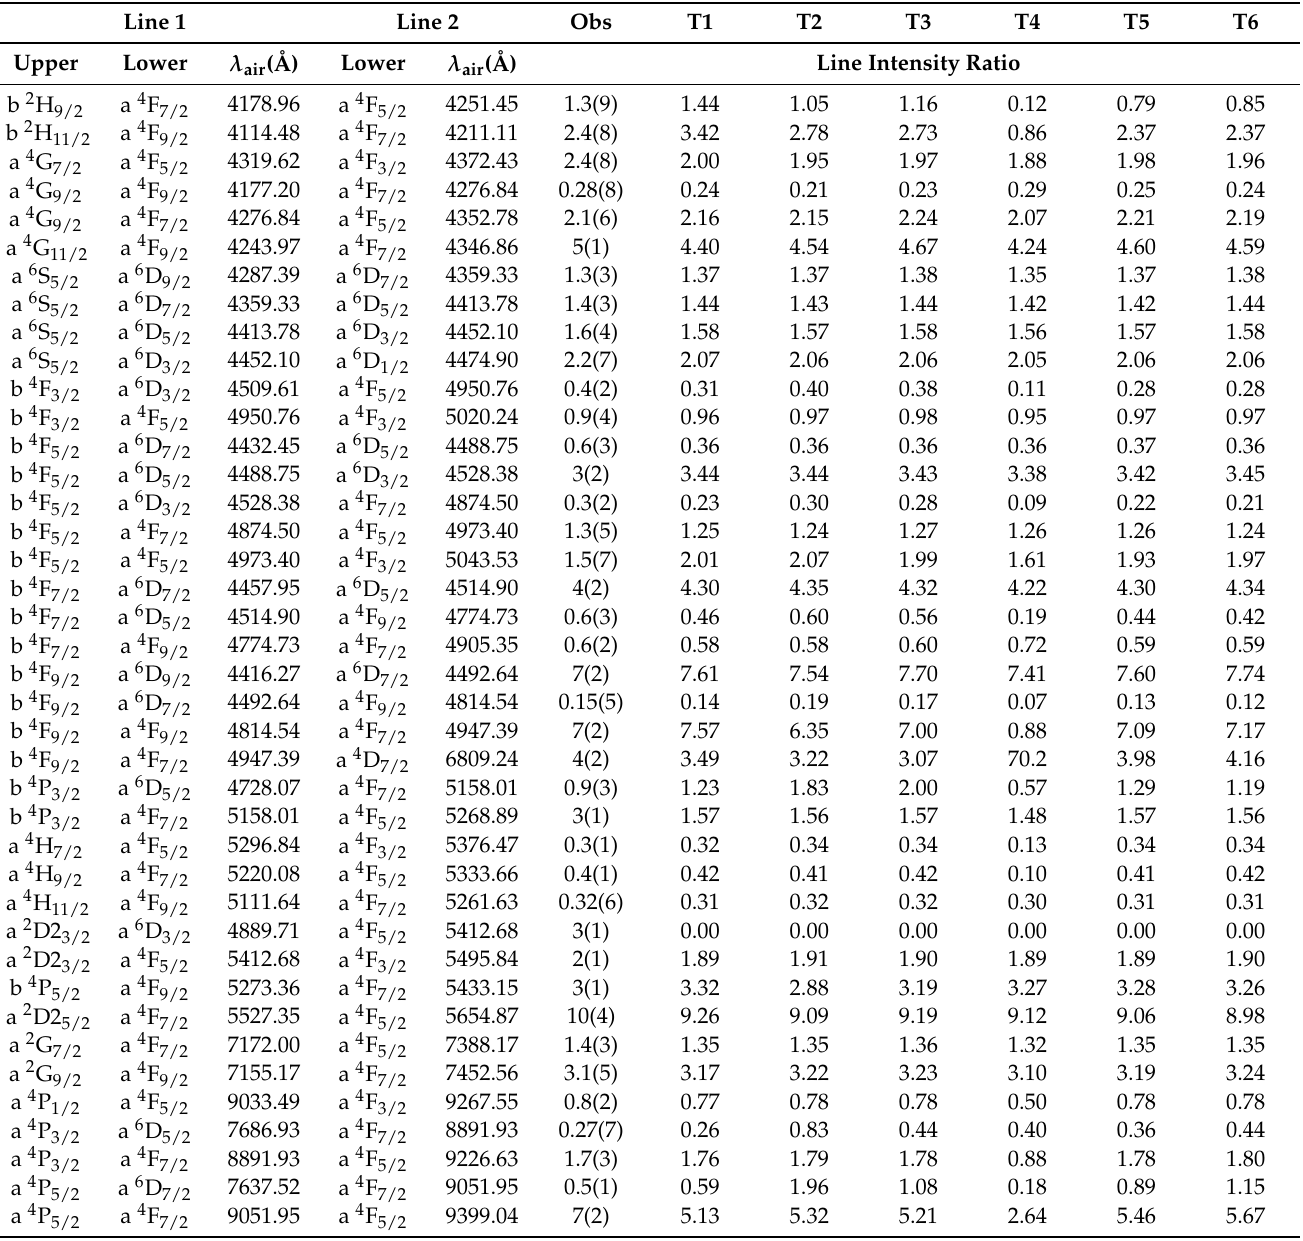
Table 8. Comparison of [Fe II ] line-intensity ratios for transitions arising from a common upper level in the HH202S spectrum (Obs) with those estimated from A -values in the following atom datasets: B15_52 (T1); DH11_52 (T2); TZ18_52 (T3); SRKFB19_52 (T4); QDZa96 (T5); QDZh96 (T6). The error of the least significant figure of the observed intensity ratio is indicated in